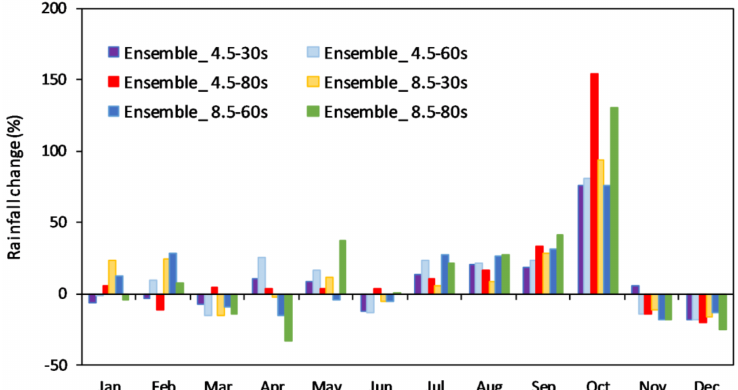
Figure 10. Relative changes in monthly rainfall in the BRB under the RCP scenarios for the 30 s, 60 s, and 80 s periods, with respect to the observed rainfall